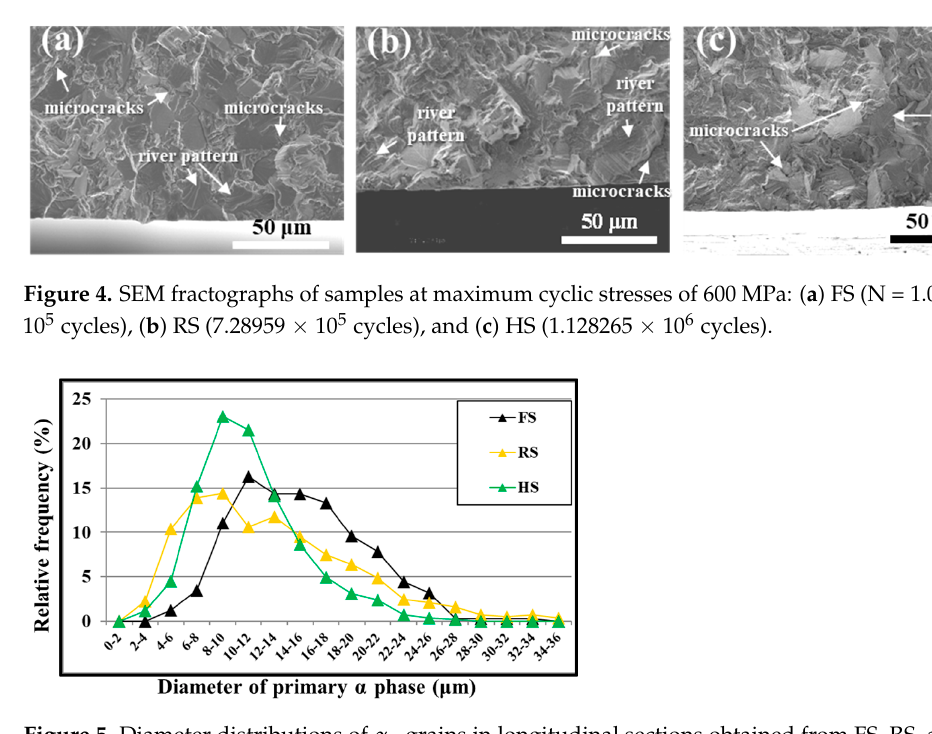
Figure 5. Diameter distributions of α p grains in longitudinal sections obtained from FS, RS, and HS.